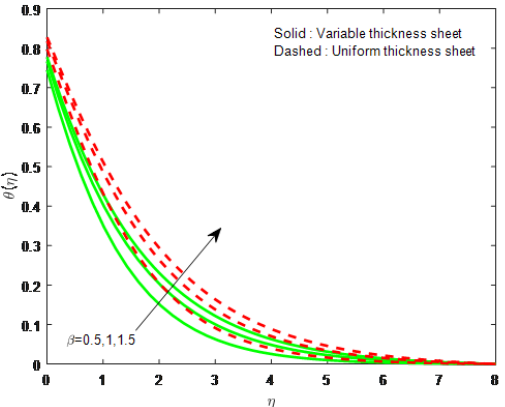
Fig. 15: Influence of h 1 on temperature field